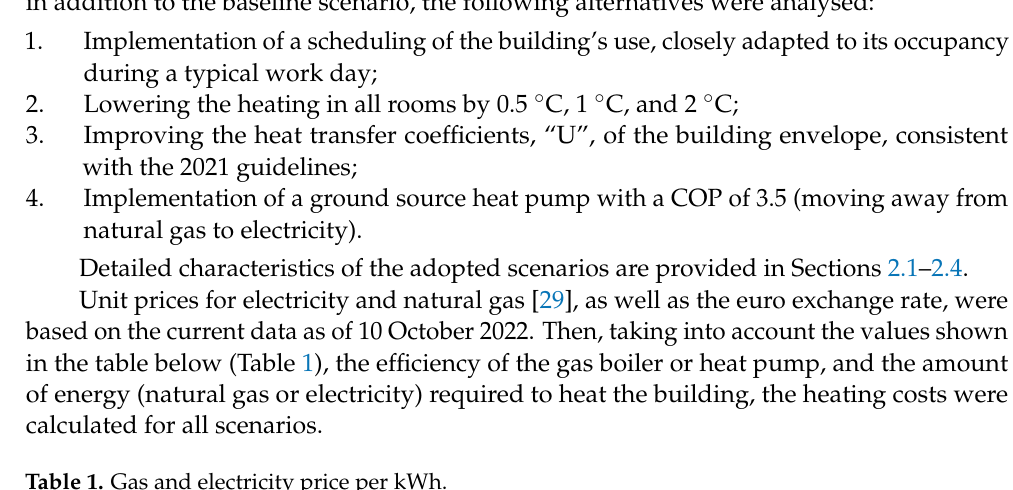
Table 1. Gas and electricity price per kWh.